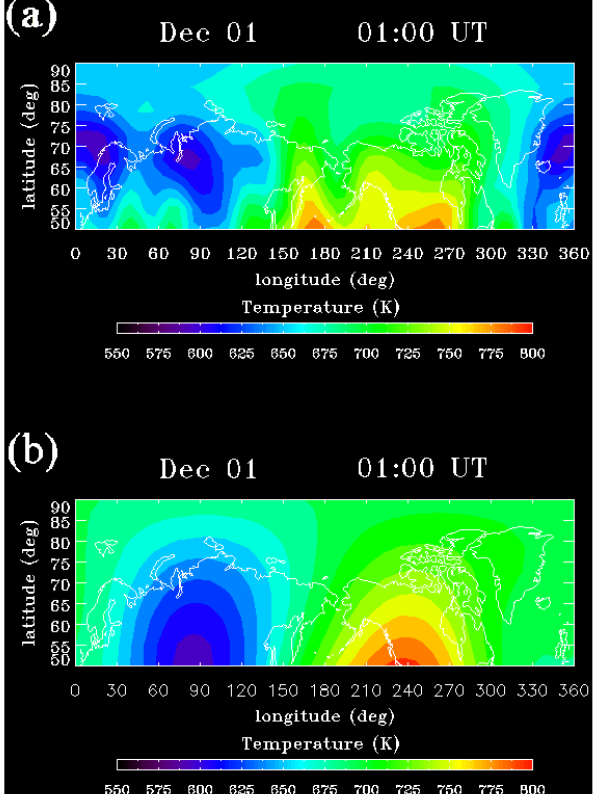
Fig. 3. Panels (a) and (b) are the same as Fig. 2a and c, respectively, except for temperature distributions in the 50 ◦ –90 ◦ latitude range in the Northern (winter) Hemisphere.